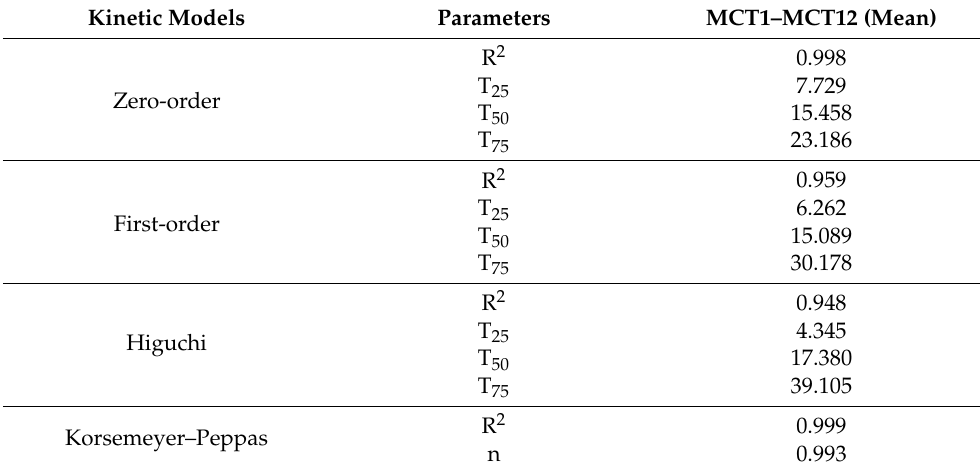
Table 2. Results of kinetic modeling of release data